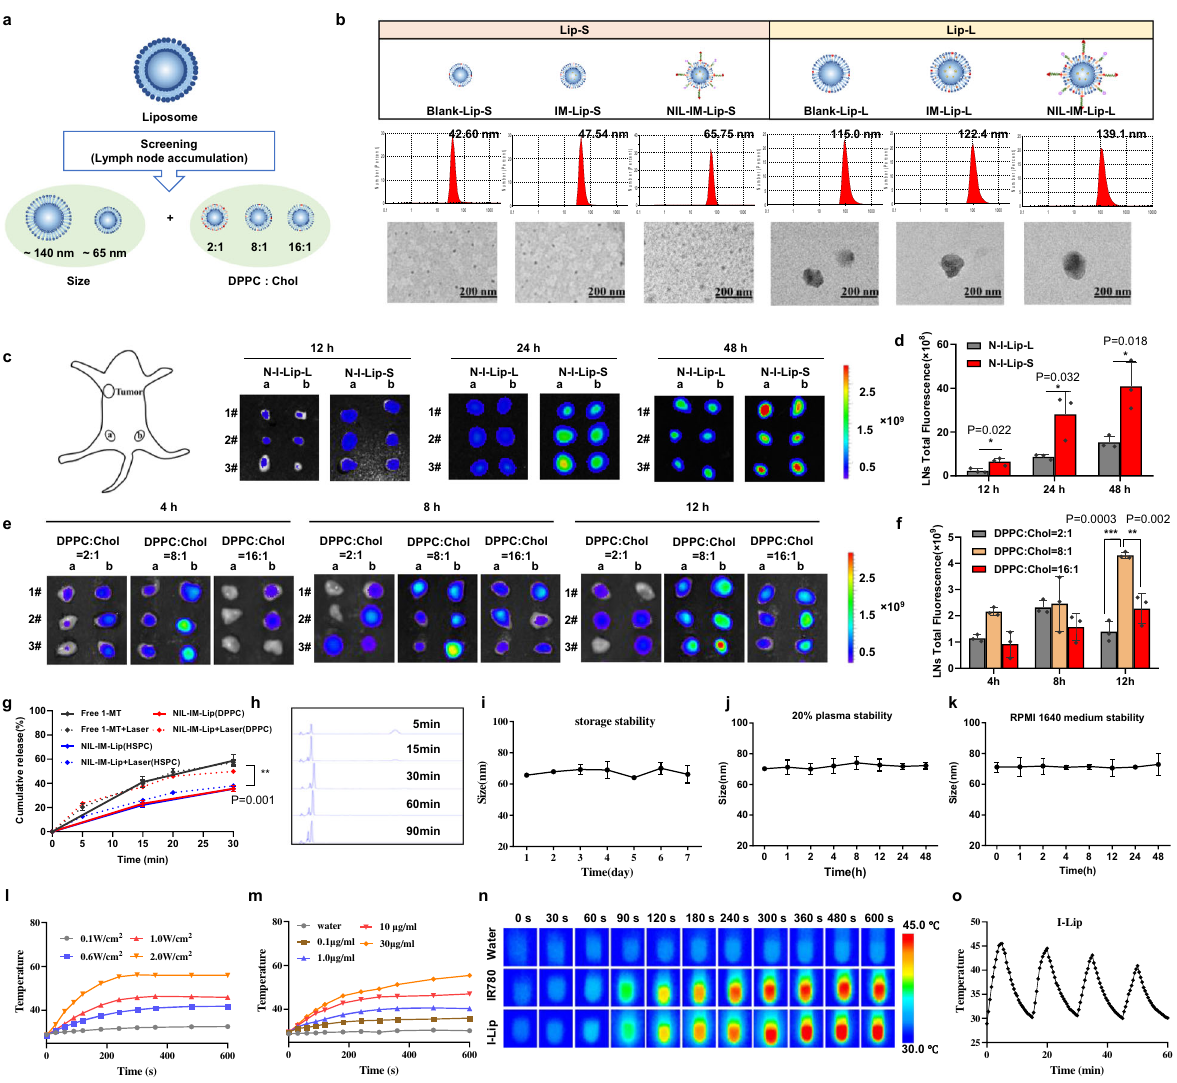
Fig. 2 | Ef fi cacy ofNIL-IM-Lip with a small sizeand 1/8mass ratio ofcholesterol on LNs directing properties, xenotype cell delivery and photothermal con- version. a Schematic illustration of the particle size and cholesterol mass